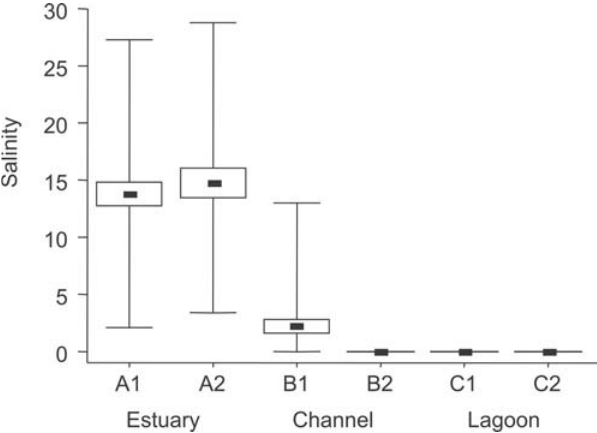
Fig. 2. Average, minimum and maximum salinity values along the Patos Lagoon estuary (A1, A2), São Gonçalo Channel (B1, B2) and Mirim Lagoon (C1,